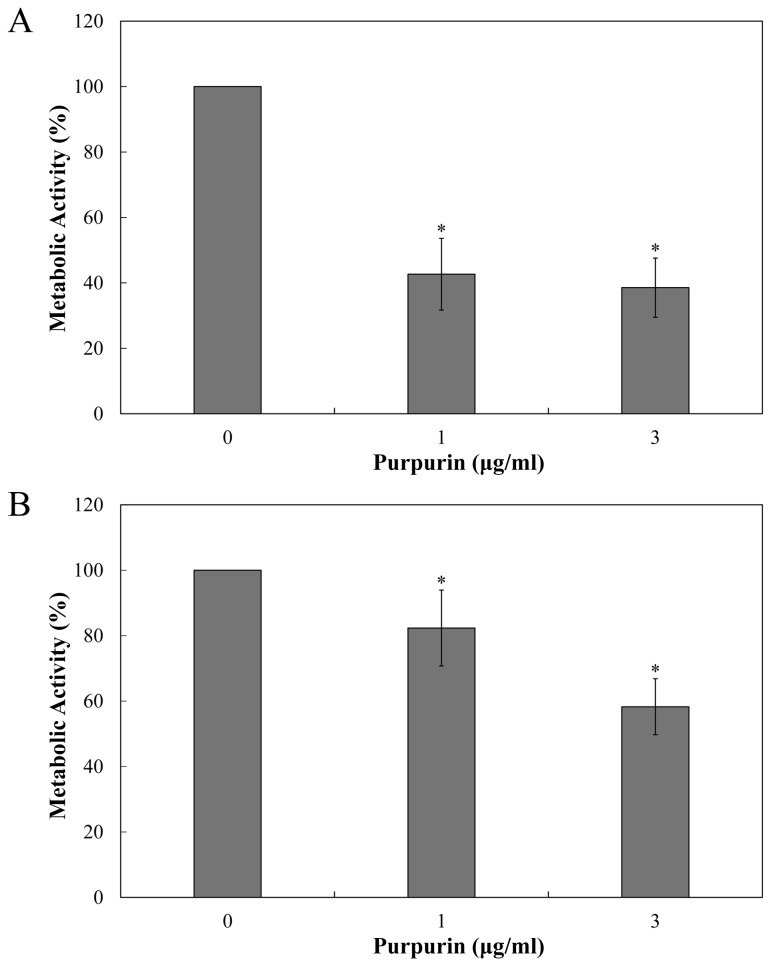
Effect of purpurin on Candida dubliniensis biofilms.A) Biofilm formation of C. dubliniensis MYA-646. B) Mature biofilms. In both cases, biofilms were incubated with the indicated concentration of purpurin for 24 h at 37°C. The metabolic activity of the biofilms was assessed semi-quantitatively using XTT reduction assay. The activity of samples without purpurin treatment (i.e. DMSO only) (0 µg/ml) was taken as 100%. Results shown were the average of three independent experiments ± SD. *p<0.05 when compared with the untreated controls.